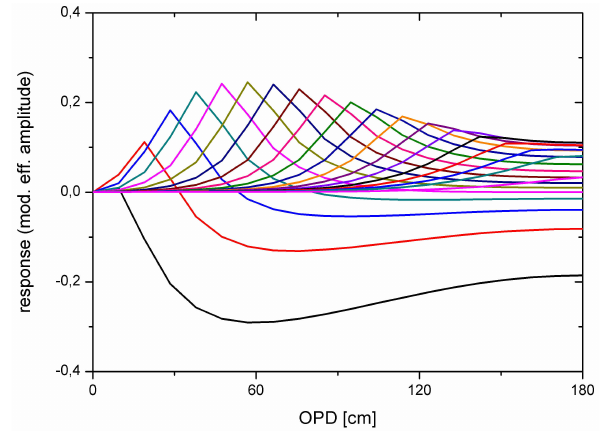
Fig. 3. The averaging kernels of the ILS retrieval from the HBr cell (the modulation amplitude kernels are shown).